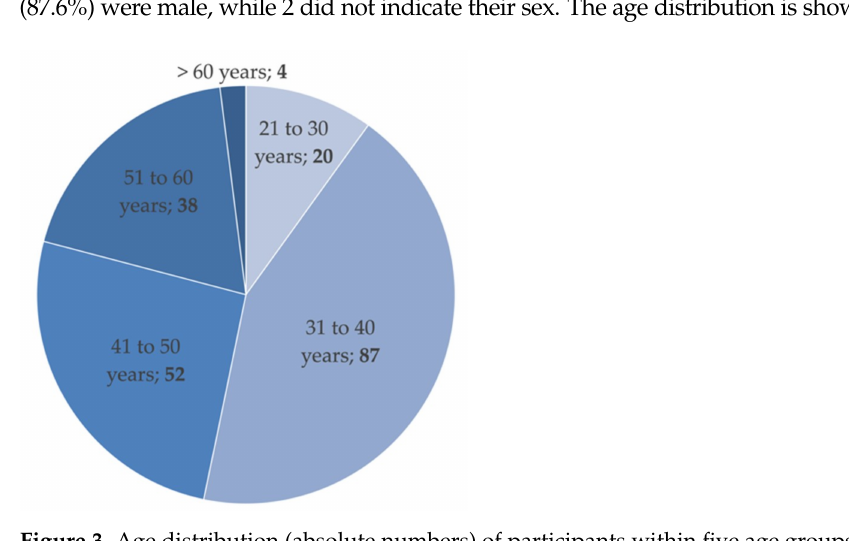
Figure 3. Age distribution (absolute numbers) of participants within five age